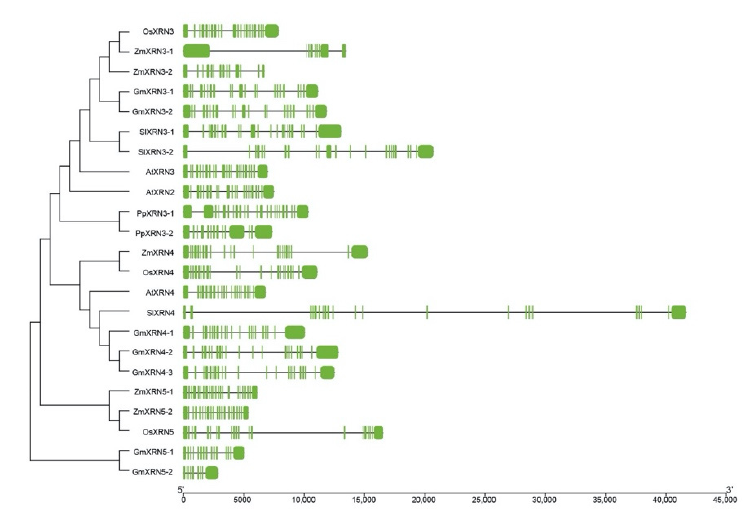
Figure 2. The gene structure of XRNs proteins in 6 plant species displaying with the same order as polygenetic tree. Exons and introns are shown as green boxes and black lines, respectively.